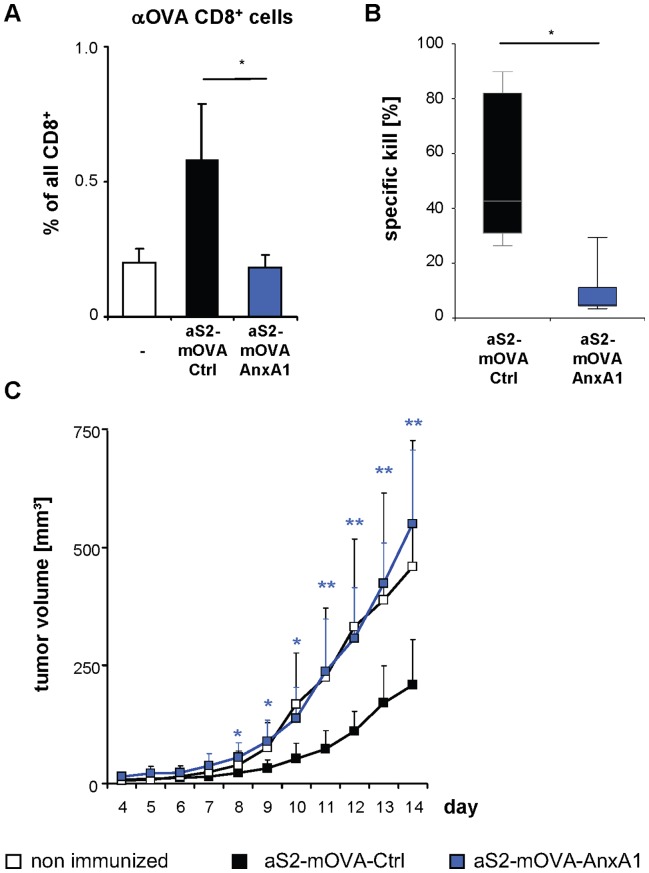
Annexin A1 suppresses immune responses in vivo.(A) Apoptotic, mOVA-expressing Drosophila Schneider cells (aS2-mOVA) transfected with annexin A1 (AnxA1) or a control plasmid (Ctrl) were injected into mice. After 8 days, percentages of OVA-specific CD8+ T cells relative to total CD8+ T cells in lymph nodes were analyzed by flow cytometry. *P<0.05 (n = 5). (B) Mice were immunized as in (A) and challenged with OVA/CpG after 10 days. CD8+ T cell function was analyzed by an in vivo cytolytic assay using OVA-peptide labeled target cells (n = 4–5), *P<0.05. (C) Mice were immunized as in (A). After 12 days, mice were injected with OVA-expressing B16 melanoma cells. Tumor growth was monitored for 4 to 14 days. *P<0.05, **P<0.01 for tumors of mice immunized with annexin A1-expressing apoptotic S2-mOVA cells compared to mice immunized with apoptotic S2-mOVA cells (n = 6). Data are representative of 3 (A) or 2 (B, C) independent experiments.